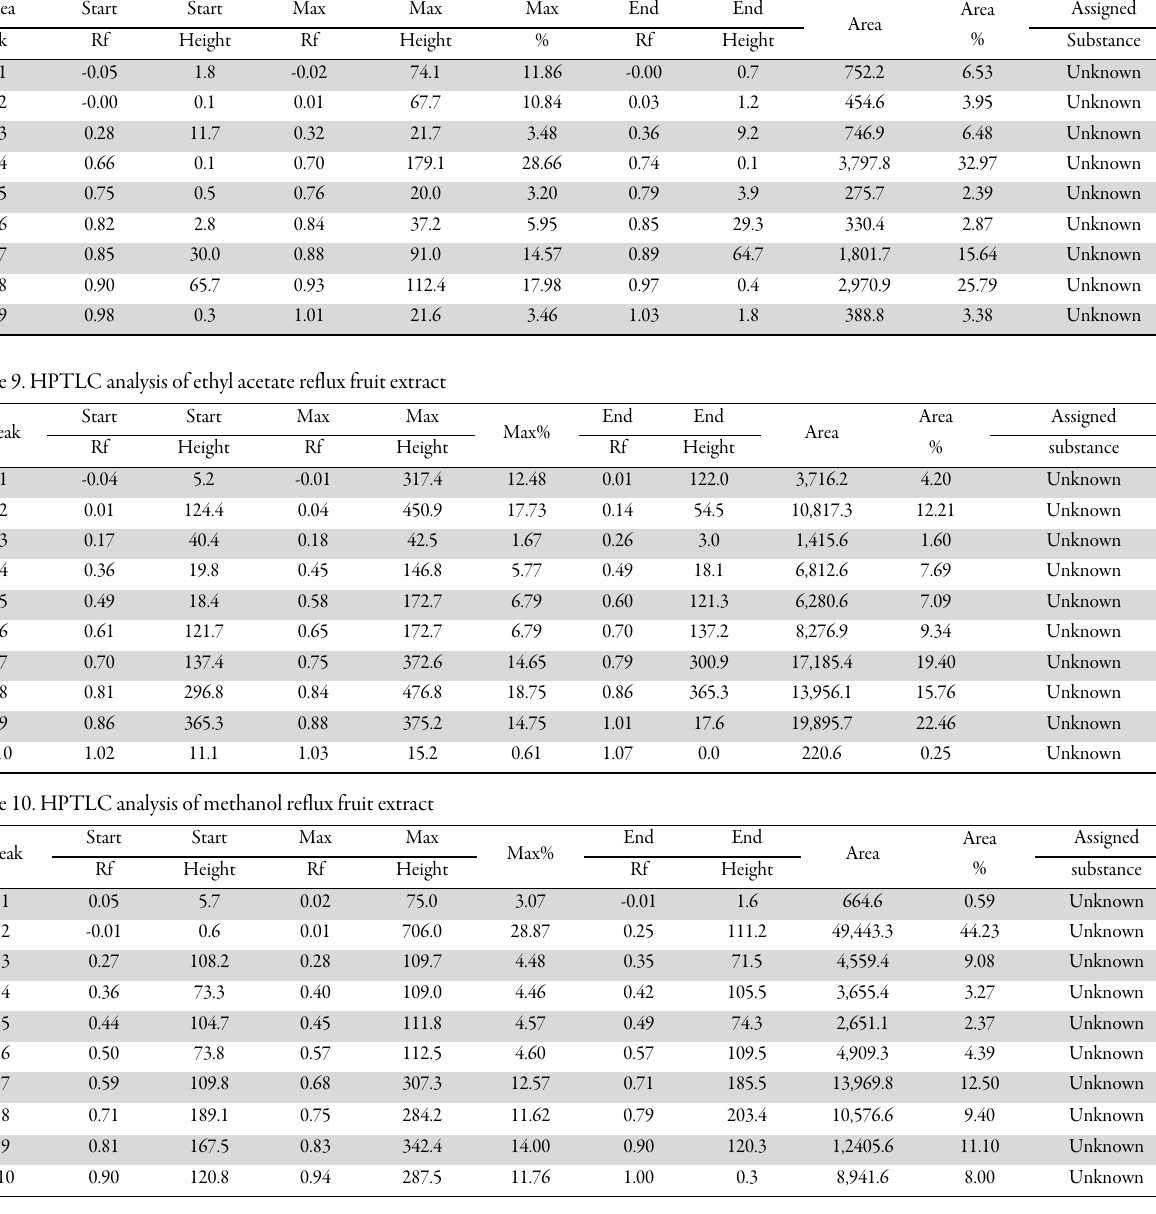
Table 8. HPTLC analysis of hexane reflux fruit extract Pea